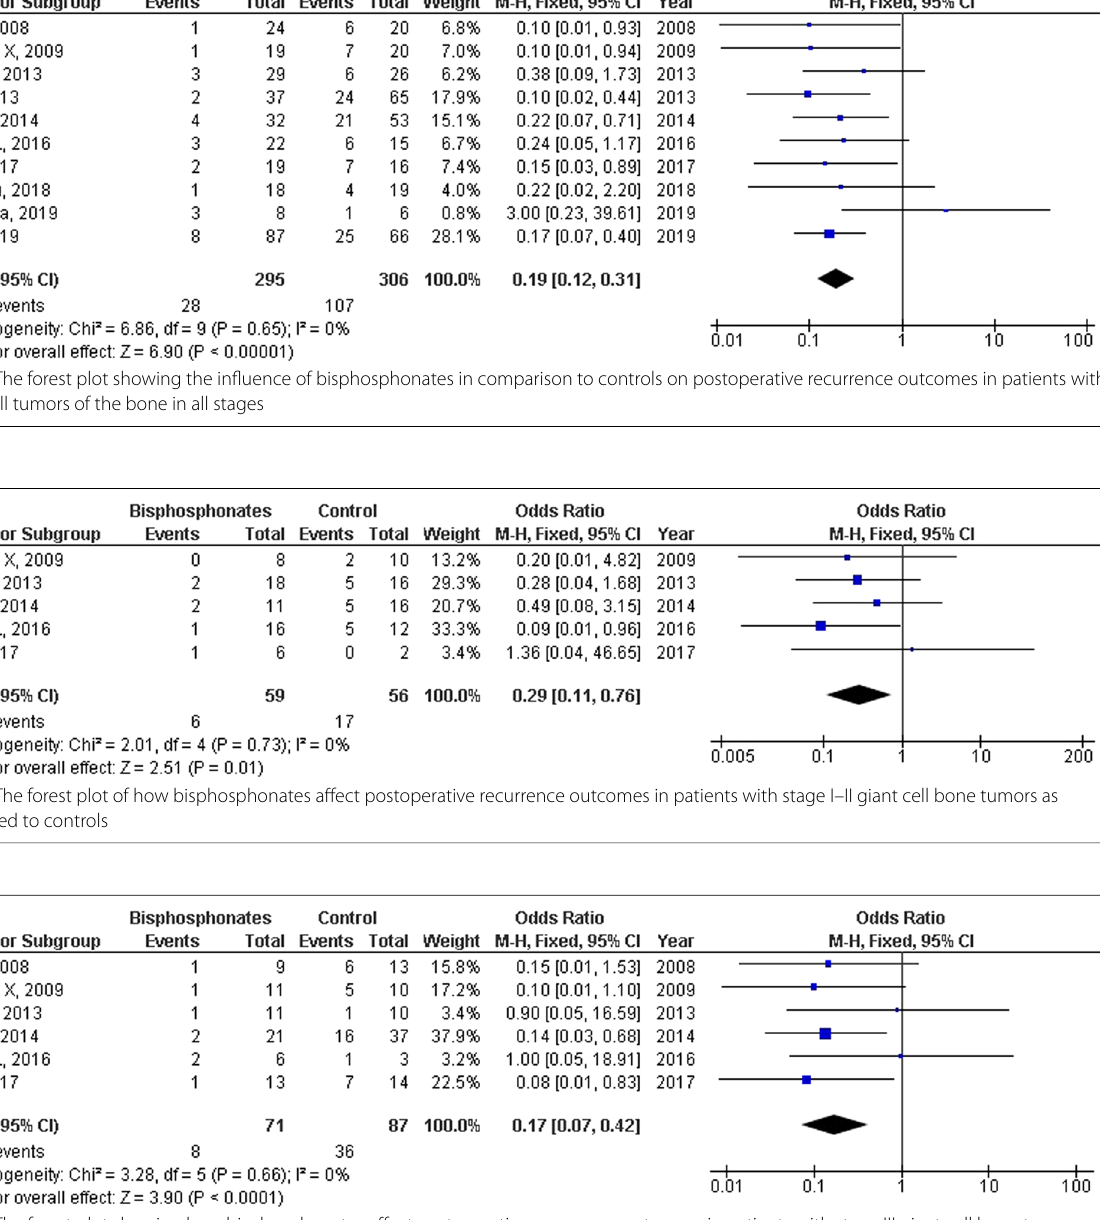
Fig. 4 The forest plot showing how bisphosphonates affect postoperative recurrence outcomes in patients with stage III giant cell bone tumors when compared to